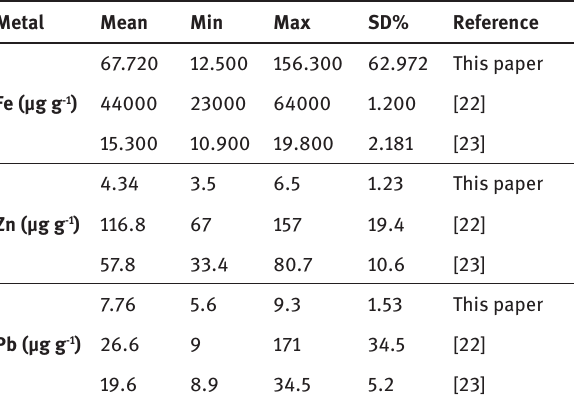
Table 5: The comparison of the metal content in soil from different